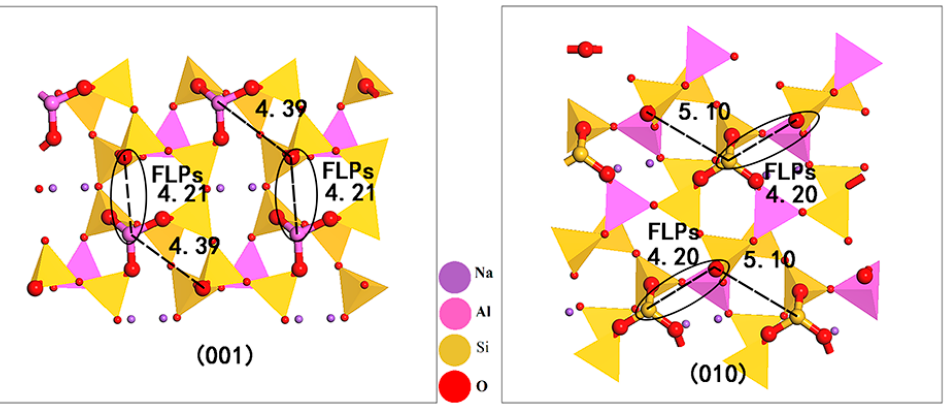
Figure 1. Schematic diagram of the albite (001) and (010) surface model. The circle indicates the FLPs position and the dotted lines indicates the distance between Lewis acid and Lewis base.